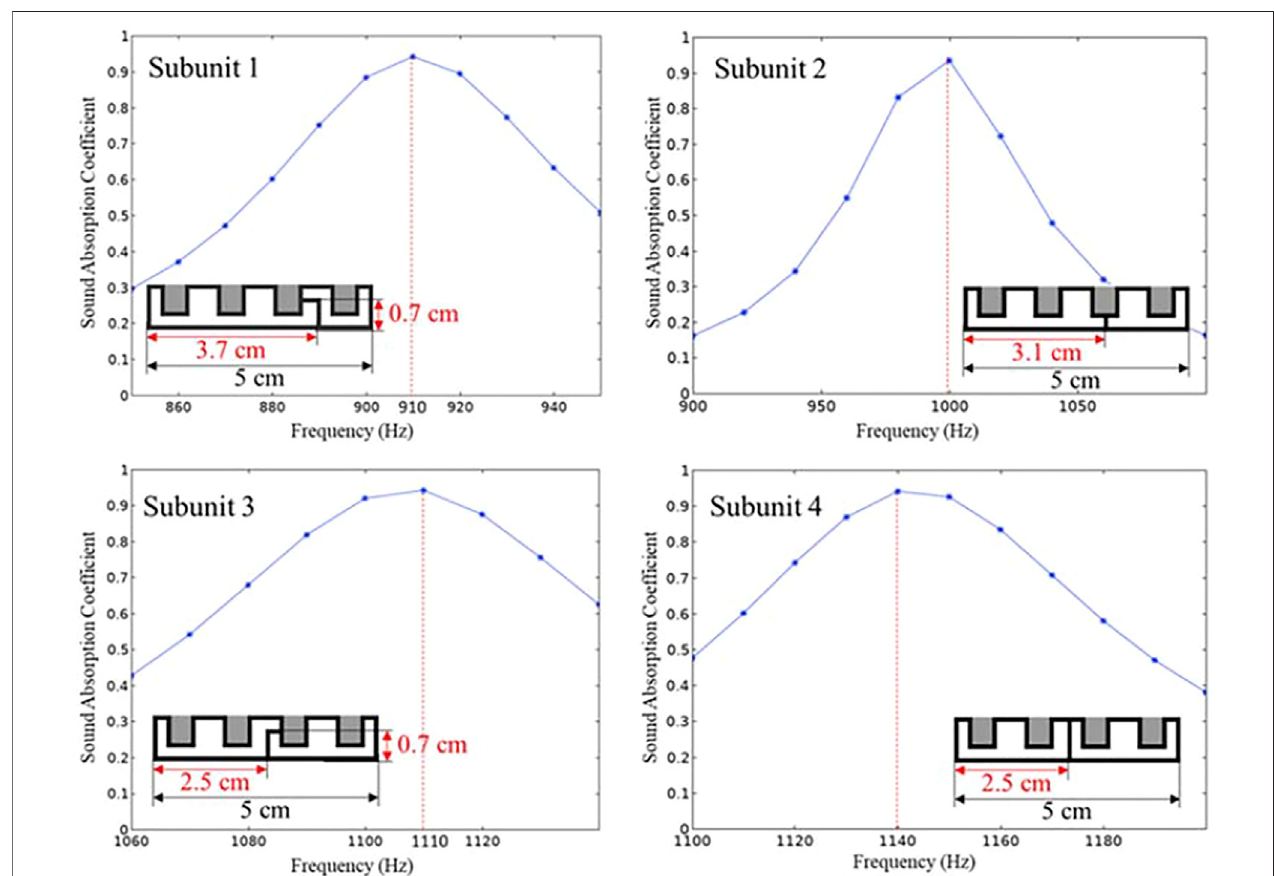
FIGURE 3 | Sound absorption coef fi cient of each